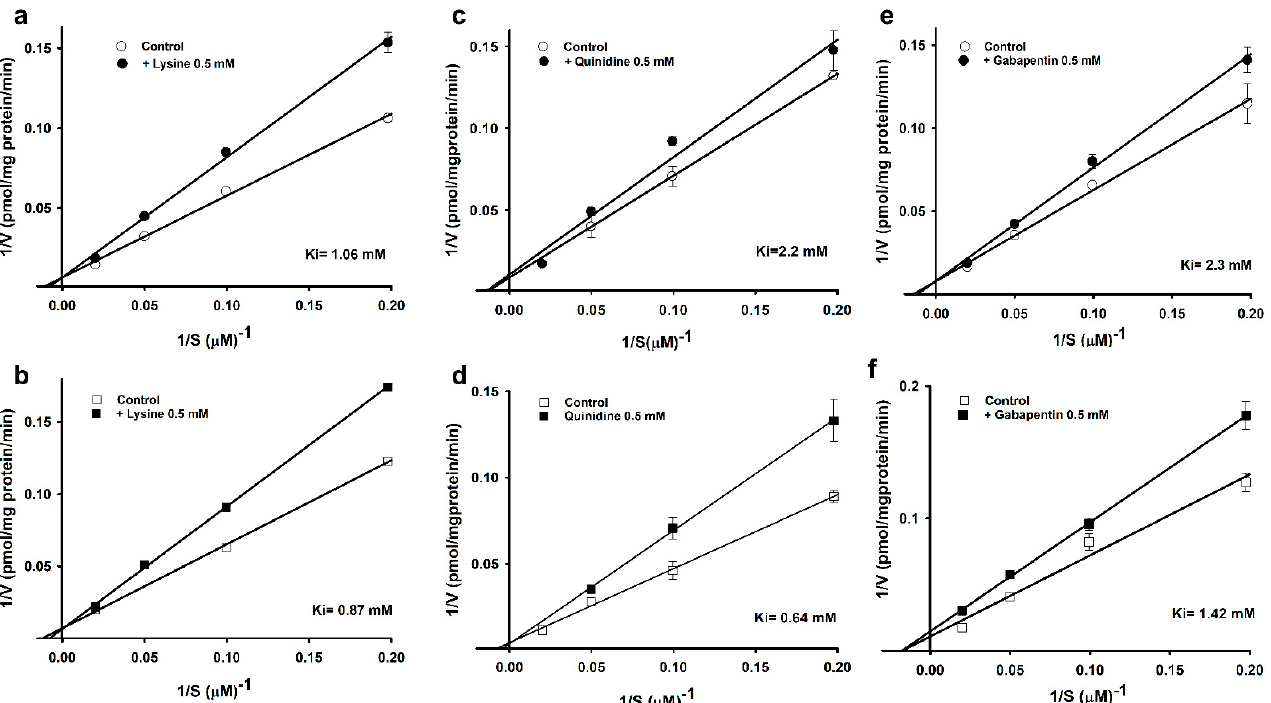
Figure 2. Line weaver–Burk plot of [ 3 H]L-arginine uptake by ALS cell lines. [ 3 H]L-arginine uptake was observed at pH 7.4 and 37 °C for 5 min in the presence of 0.5 mM of lysine ( a , b ), quinidine ( c , d ), and gabapentin ( e , f ) or their absence in WT (circle) and MT (square) cell lines. Each data point represents the mean ± SEM ( n = 3–4). 2.2 mM, and competitive inhibition in the MT cell lines, with a Ki value of 0.64 mM (Figure